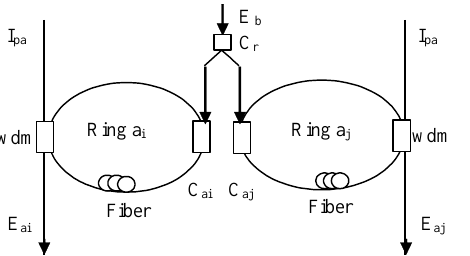
Fig.2 . The two receivers based on two independent erbium-doped fiber ring lasers as “passive subsystems”. C r , Cai and Caj are the couplers, E ai and E aj lasing fields output from ring b ai and ring a j , respectively. E b lasing field output from ring